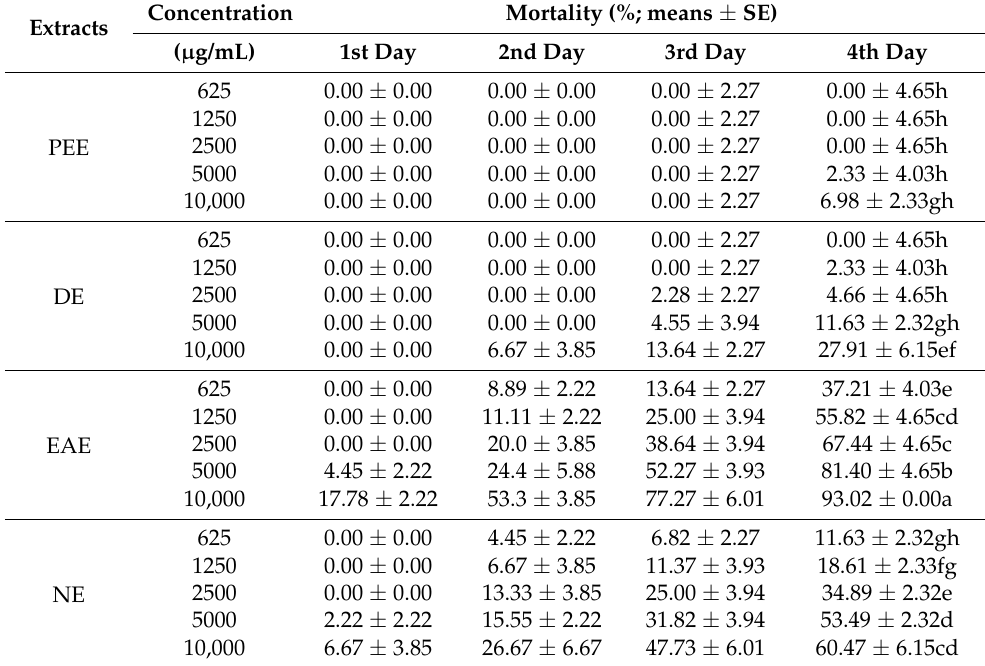
Table 2. The mortality rates of extracts of fungus BS5. Extracts